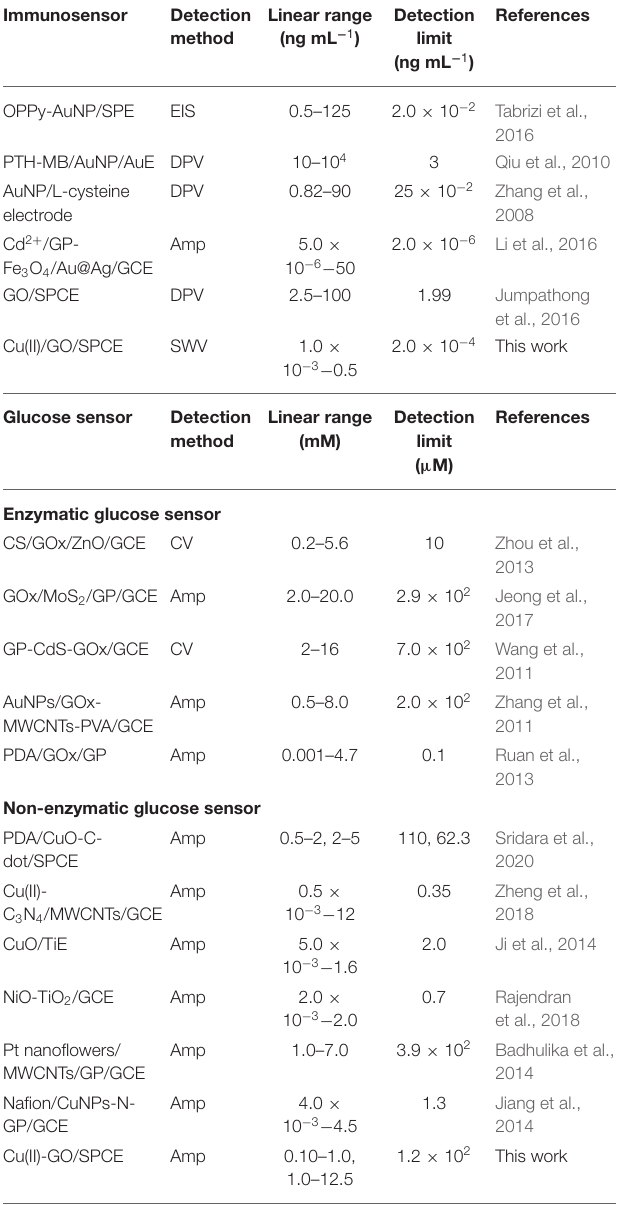
TABLE 1 | Comparison of our proposed sensors with other reported sensors.